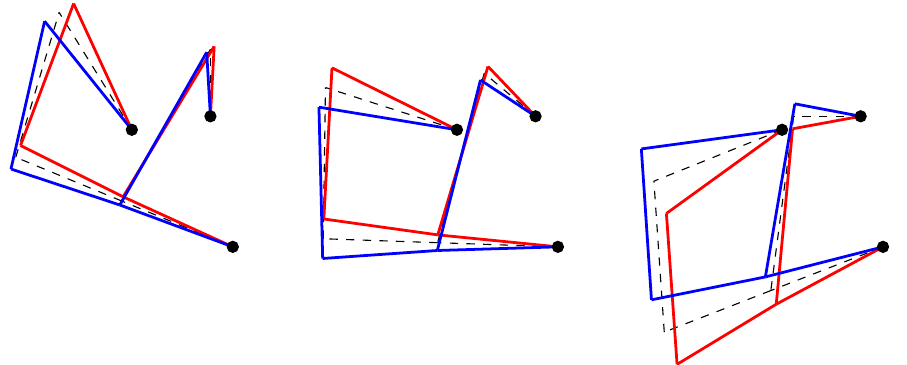
Figure 7. Mode 1 in three different configurations. ( Left ) α 3 = 90 ◦ . ( Middle ) α 3 = 140 ◦ . ( Right ) α 3 = 180 ◦ . ( ) Undeformed model; ( ) and ( ) extreme deformed configurations during oscillation.